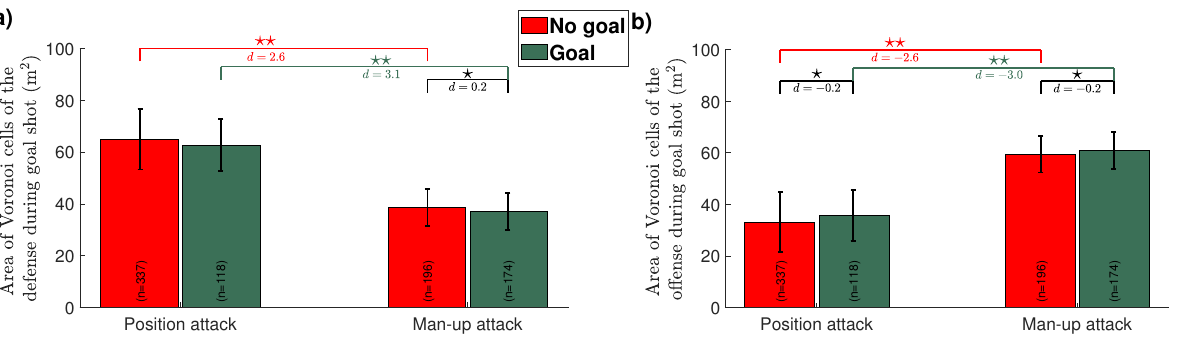
Figure 9. Collective-tactical analysis of the space control during goal throw for the ( a ) defending and ( b ) attacking team defined as the team sum of the individually controlled areas by the six team members (Voronoi-cells within a 15 m × 8 m defined rectangle in front of the goal with Cohens’ d and significances: (cid:63) stands for p < 0.05 and (cid:63)(cid:63) for p < 0.01).